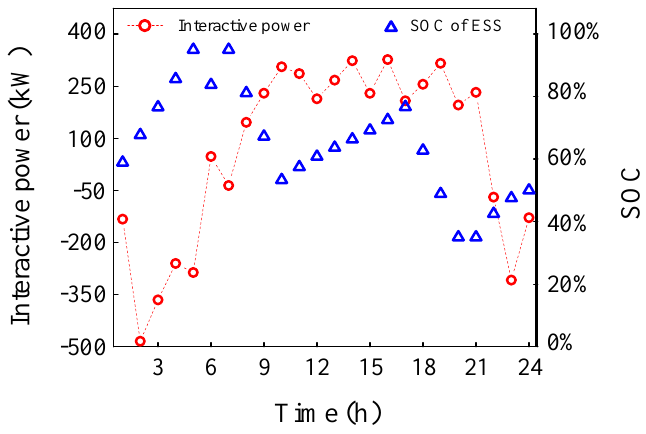
Figure 5. Microgrid Structure with deployed DGs and ESS.